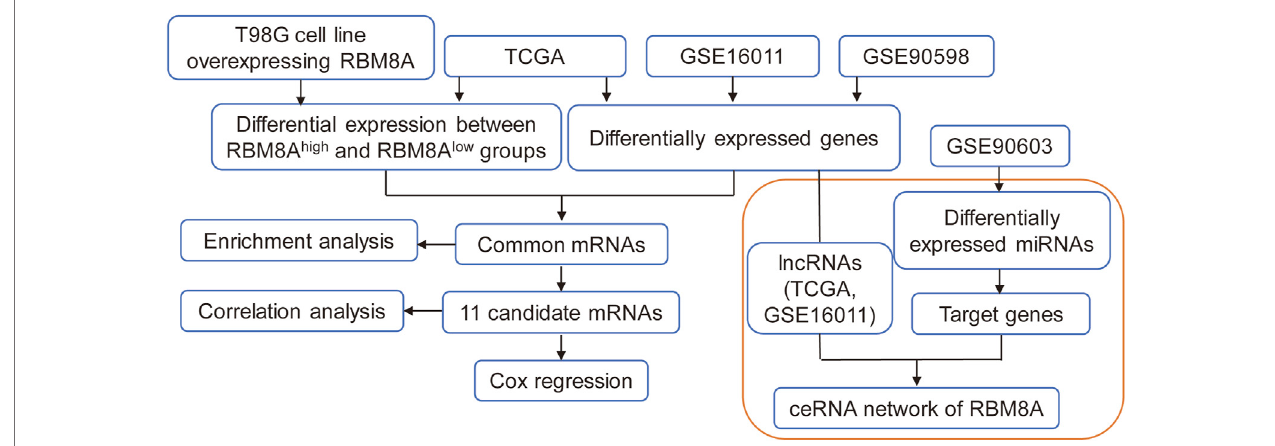
FIGURE 1 | The fl ow diagram of this study. ceRNA, competing endogenous RNAs; lncRNA, long non-coding RNAs; LASSO, least absolute shrinkage and selection operator regression; MEGENA, multiscale embedded gene coexpression network analysis; ROC, receiver operating characteristic curves; TCGA, The Cancer Genome